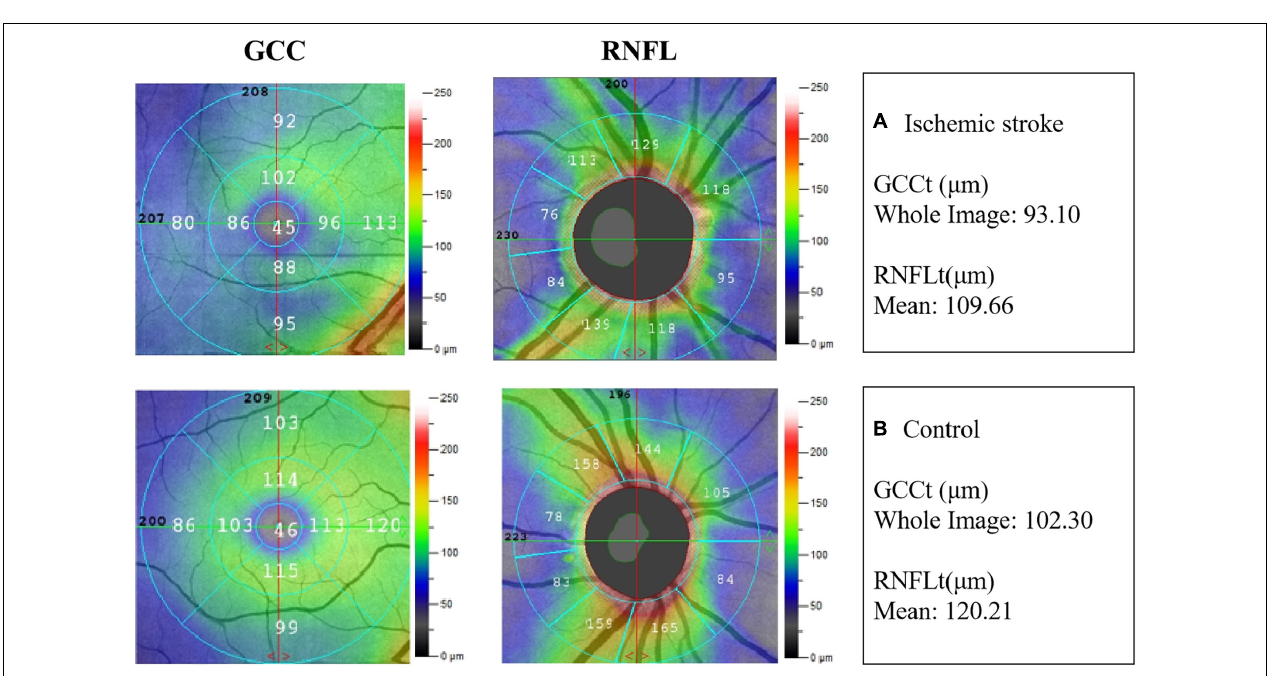
FIGURE 1 | Example images of retinal vascular density in the two groups. (A) The retinal vessel density in superficial capillary plexus (SCP), deep capillary plexus (DCP) and radial peripapillary capillaries (RPC) in IS patient. (B) The retinal vessel density in SCP, DCP and RPC in non-stroke subject.